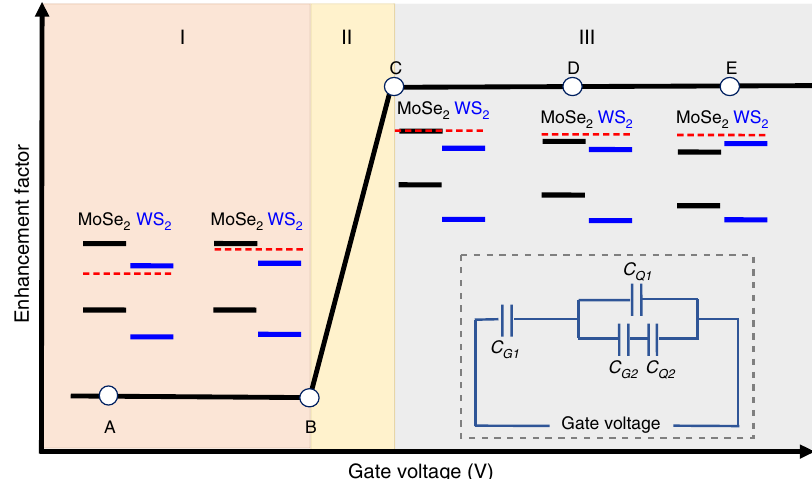
Fig. 4 Theoretical understanding of the PL quenching to PL enhancement transition. The enhancement factor as a function of the gate voltage clearly exhibits three distinct regions. Schematics of band alignment of the MoSe 2 /WS 2 heterojunction, along with the Fermi energy level (dashed line), are labeled for different points to explain the different PL enhancement factor behaviors. Inset: schematic of the effective capacitance circuit of the MoSe 2 / WS 2 heterojunction with the device con fi guration shown in Fig.